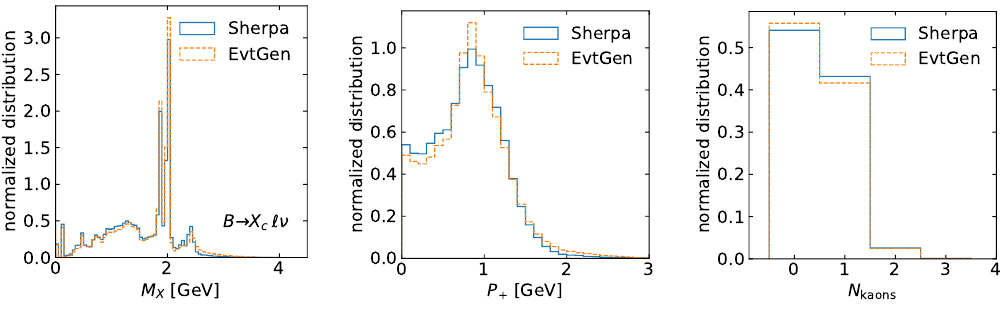
Figure 2 . High-level features of B → X c ‘ν events generated with E VT G EN and S HERPA .